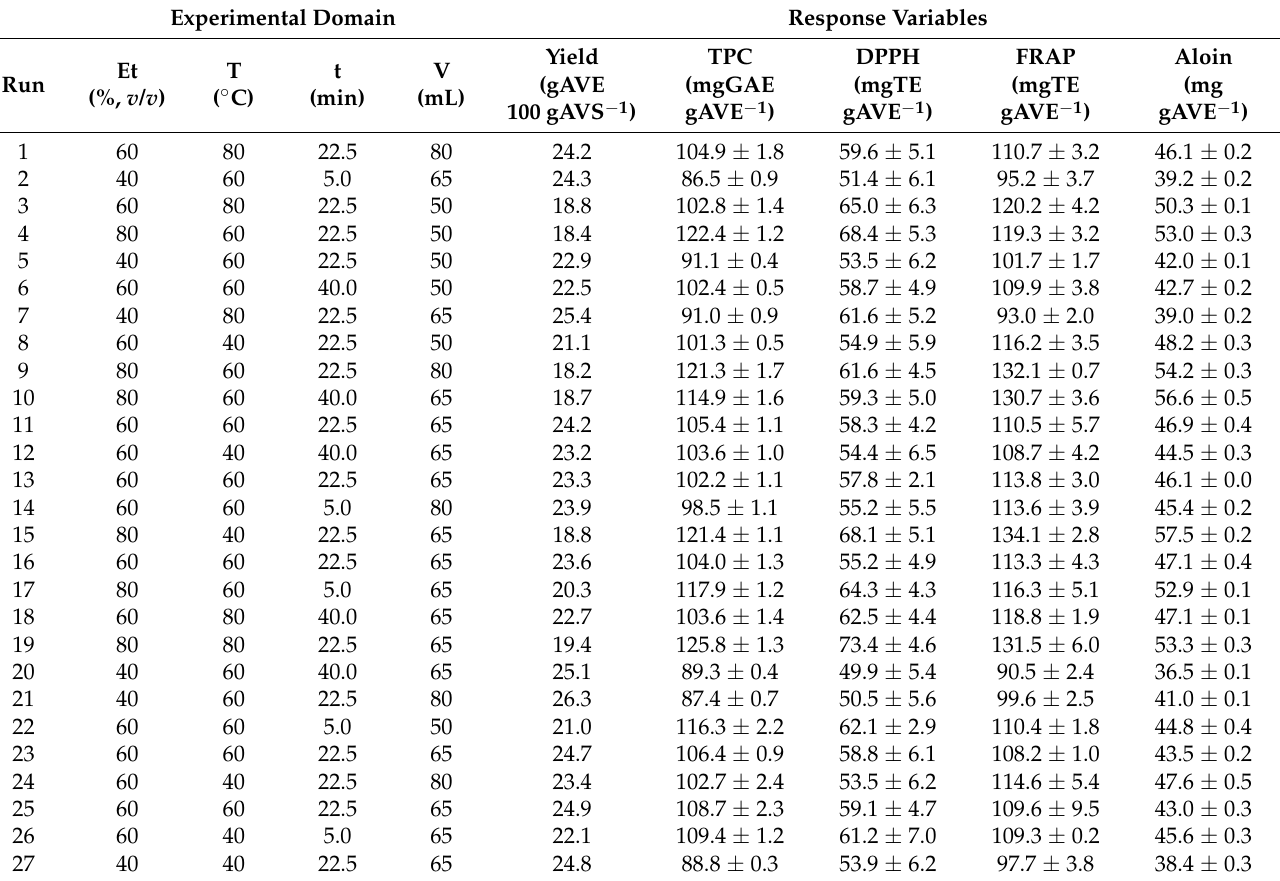
Table 2. Box-Behnken experimental design matrix and response values obtained from Aloe vera skin extracts using microwave-assisted extraction